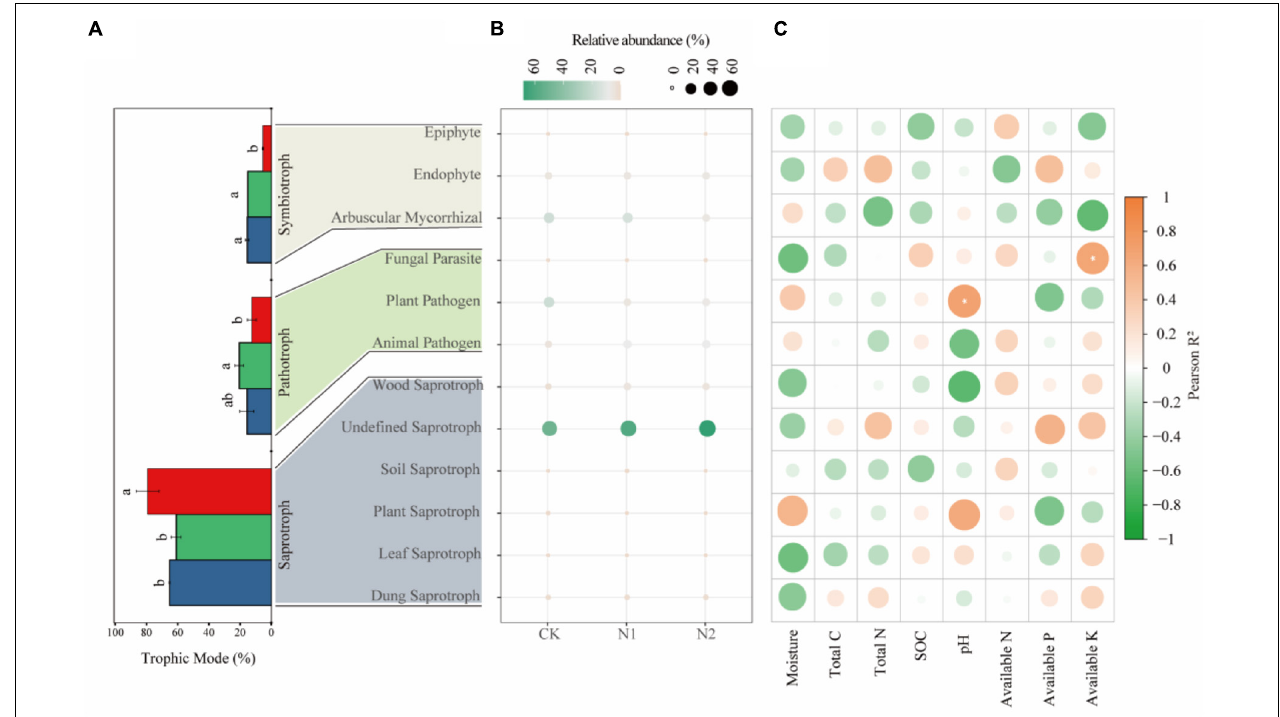
FIGURE 6 | Changes in soil fungi according to main trophic modes and guild categories (FUNGuild) after N application. (A) Changes in fungi according to trophic mode. The same lowercase letter indicates no significant difference, but the difference is significant at the 0.05 level. (B) Main fungal guilds. Colors indicate different fungal types, and circle sizes indicate their relative abundance. (C) Correlation between fungal function and soil factors. * P < 0.05.